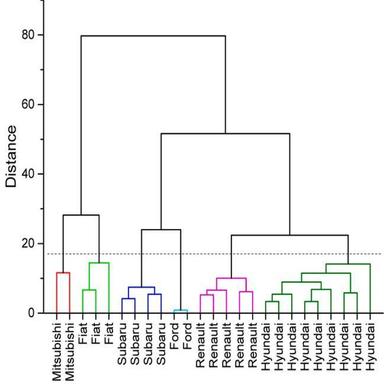
Hierarchy Cluster Analysis (HCA) tree dendogram utilizing trace elemental concentrations.